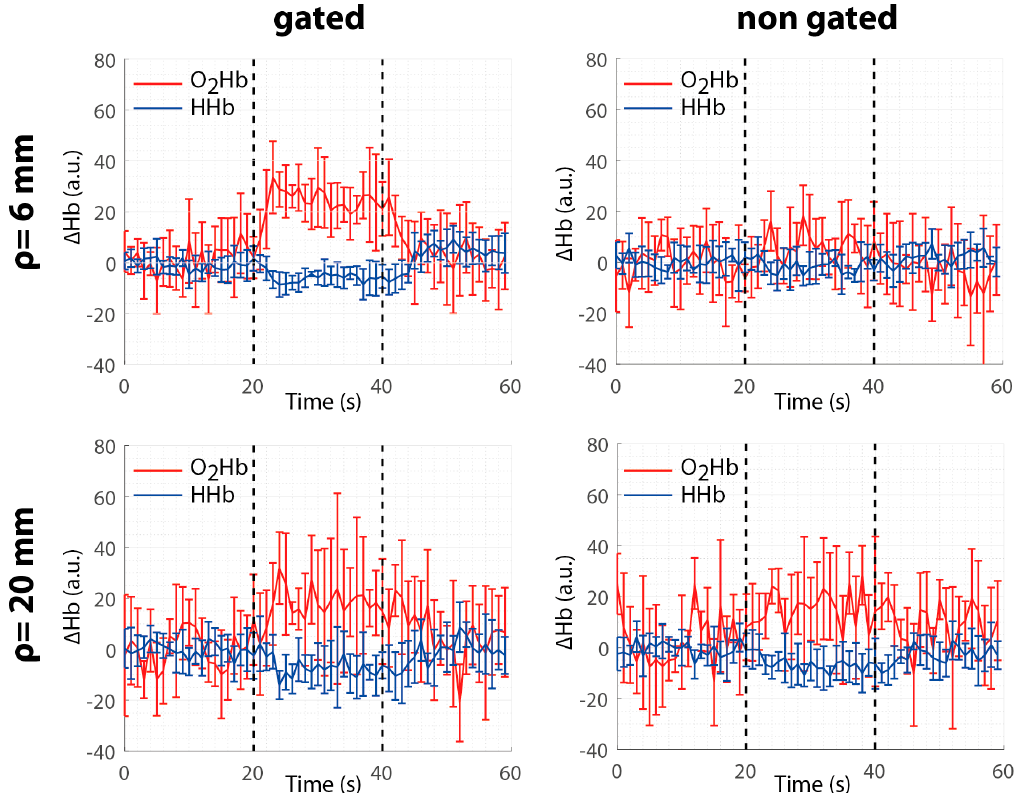
Figure 3. In vivo measurements of subject 1. Changes in O 2 Hb (red) and HHb (blue) averaged over the five repetitions of finger tapping with the contralateral hand for the gated and non-gated approach (left and right column, respectively) at the short and long distance (upper and bottom lines, respectively). Error bars represent the standard deviation over the five repetitions.